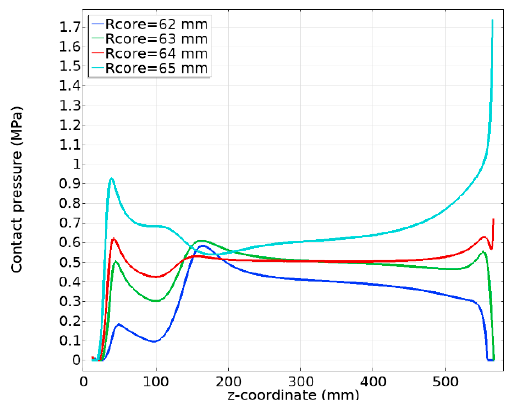
Figure 10. The contact pressure distribution between the stress cone and the cable core varies against different cable core radii. The total spring force is 30 kN for each curve.